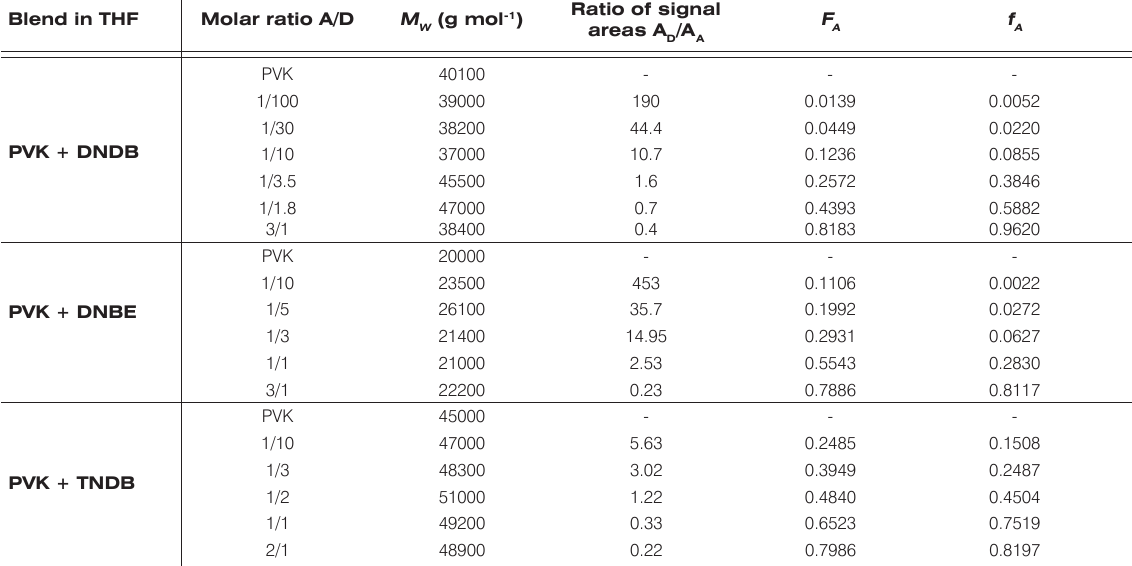
Table 1. Chromatographic data.